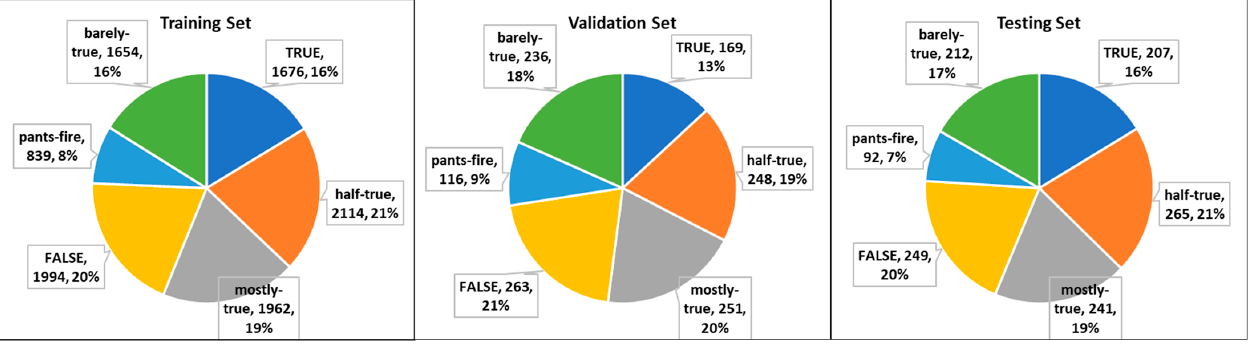
Figure 4. Samples distribution of the LIAR datasets. Table 1. Number of Samples in the LIAR Dataset.